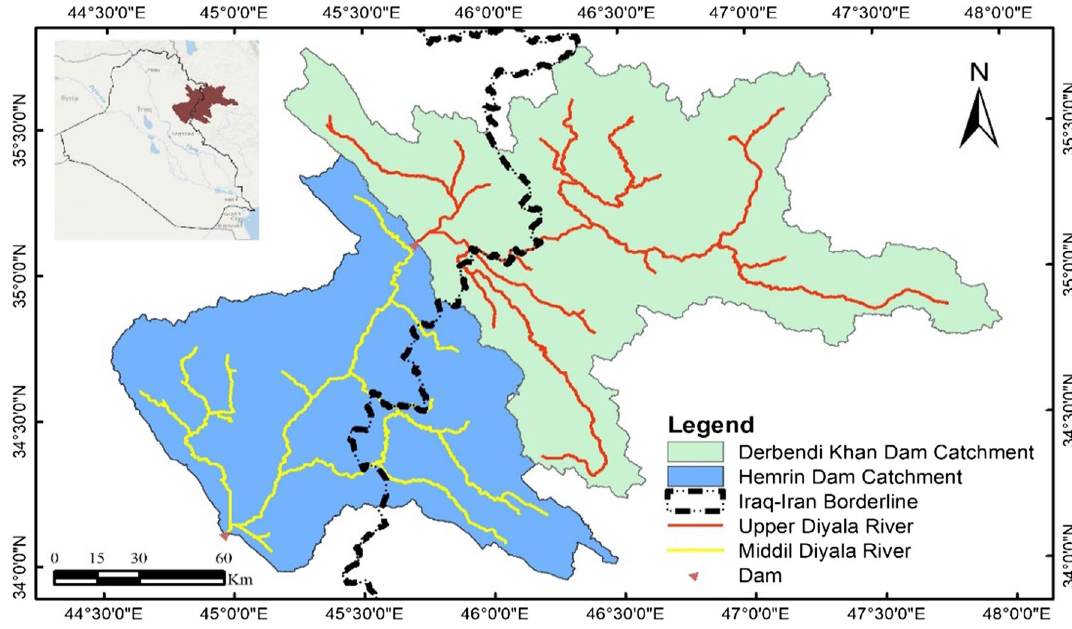
Fig. 1 Location of the studied catchment